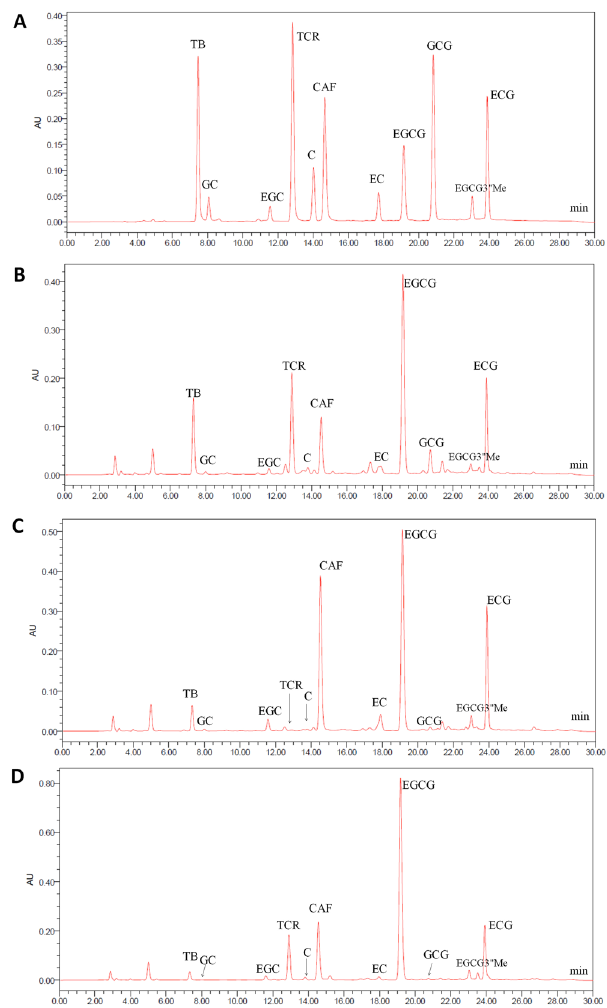
Figure 3. HPLC chromatograms of standard and three accessions of tea germplasms. ( A ) standard, ( B ) Ruyuan Qunti, ( C ) Benifuuki, ( D ) Baiyacha. Peak identification: TB, theobromine; GC, ( + )-gallocatechin; EGC, ( − )-epigallocatechin; TCR, theacrine; C, ( + )-catechin; CAF, caffeine; EC, ( − )-epicatechin; EGCG, ( − )-epigallocatechin-3-gallate; GCG, ( − )-gallocatechin-3-gallate; EGCG3 ″ Me, 3 ″ -methyl-epigallocatechin gallate; ECG, ( −